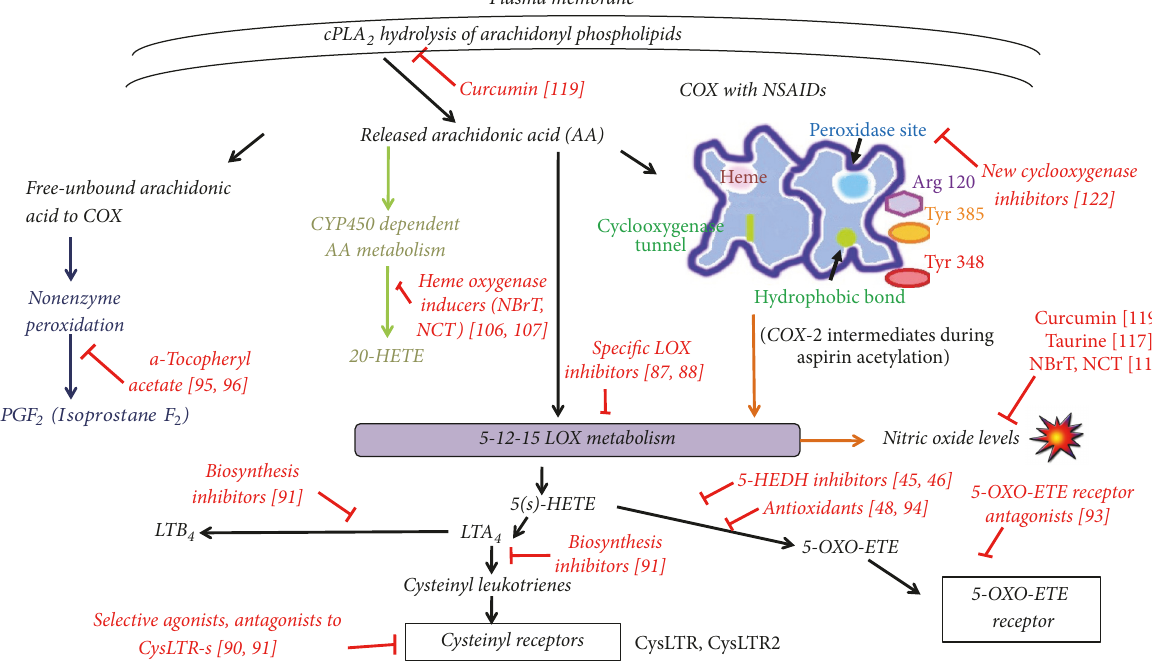
Figure 4: Possible target points of supplementary agent’s use to alleviate NSAID promotion of proinflammatory and cancerous conditions.